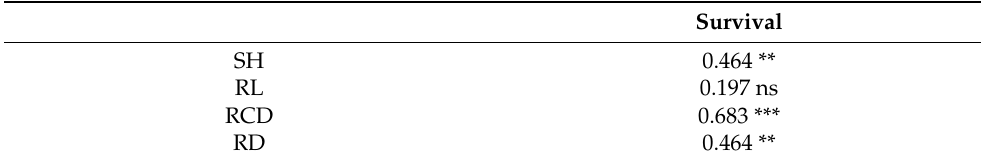
Table A1. Pearson correlations between survival and growth of seedlings of woodland trees, 9 months after planting. RCD: diameter of the stem at collar level, RD: diameter of the root at 15 cm from collar level; SH: height of the stem and RL: the root length. ***: p ≤ 0.001; **: p ≤ 0.01 and ns: not significant ( p > 0.05).